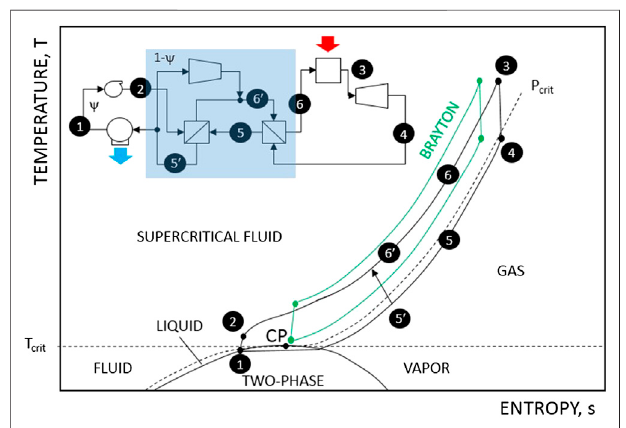
FIGURE 10 | Supercritical CO 2 Rankine cycle with split- fl ow and recompression (turbomachinery isentropic ef fi ciencies > 90%, recuperator effectiveness >